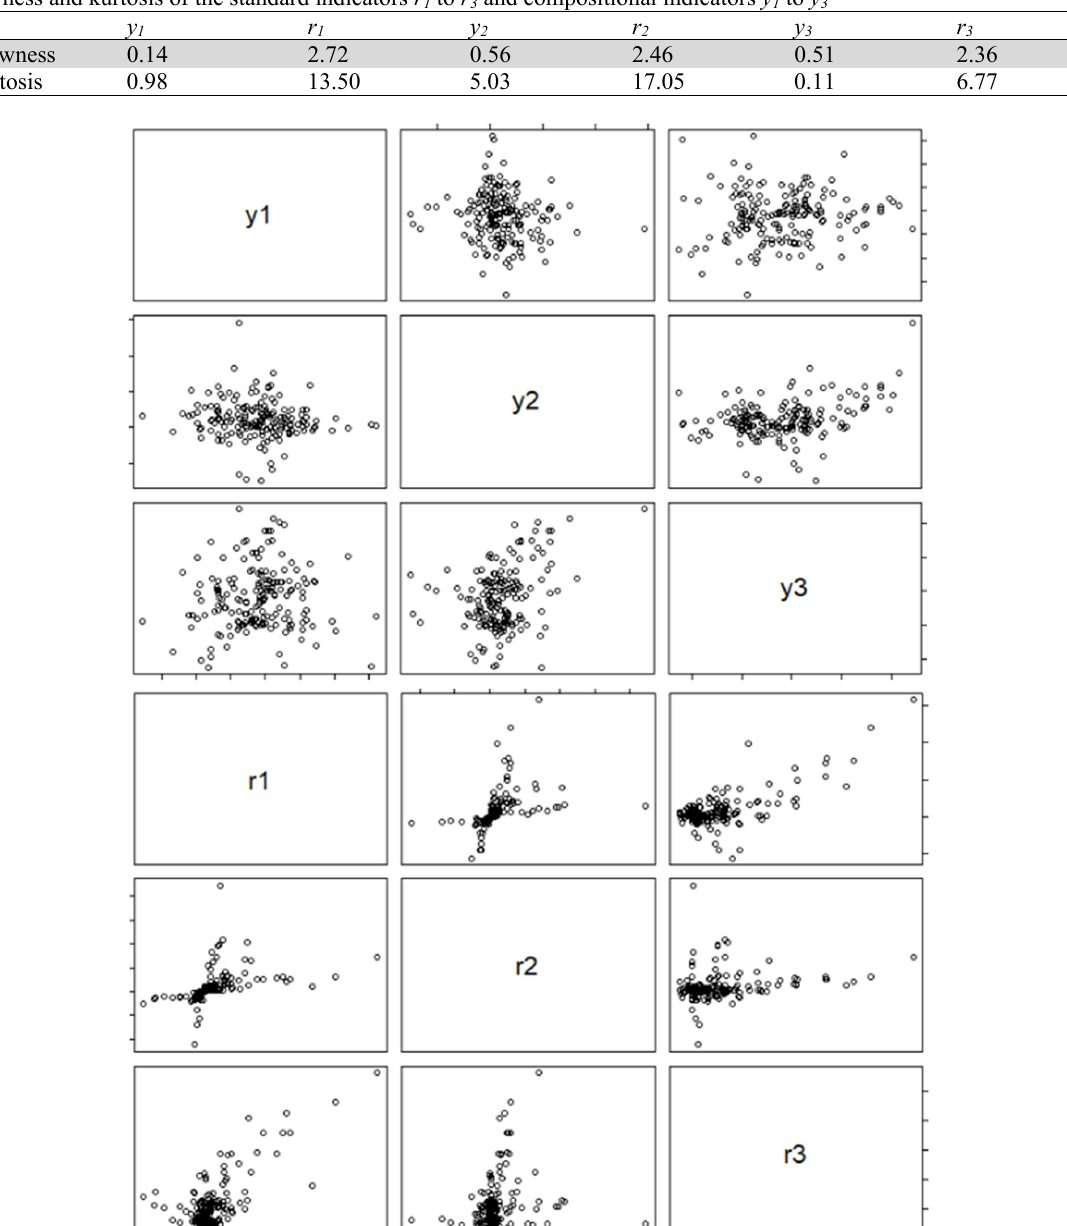
Skewness and kurtosis of the standard indicators r 1 to r 3 and compositional indicators y 1 to y 3